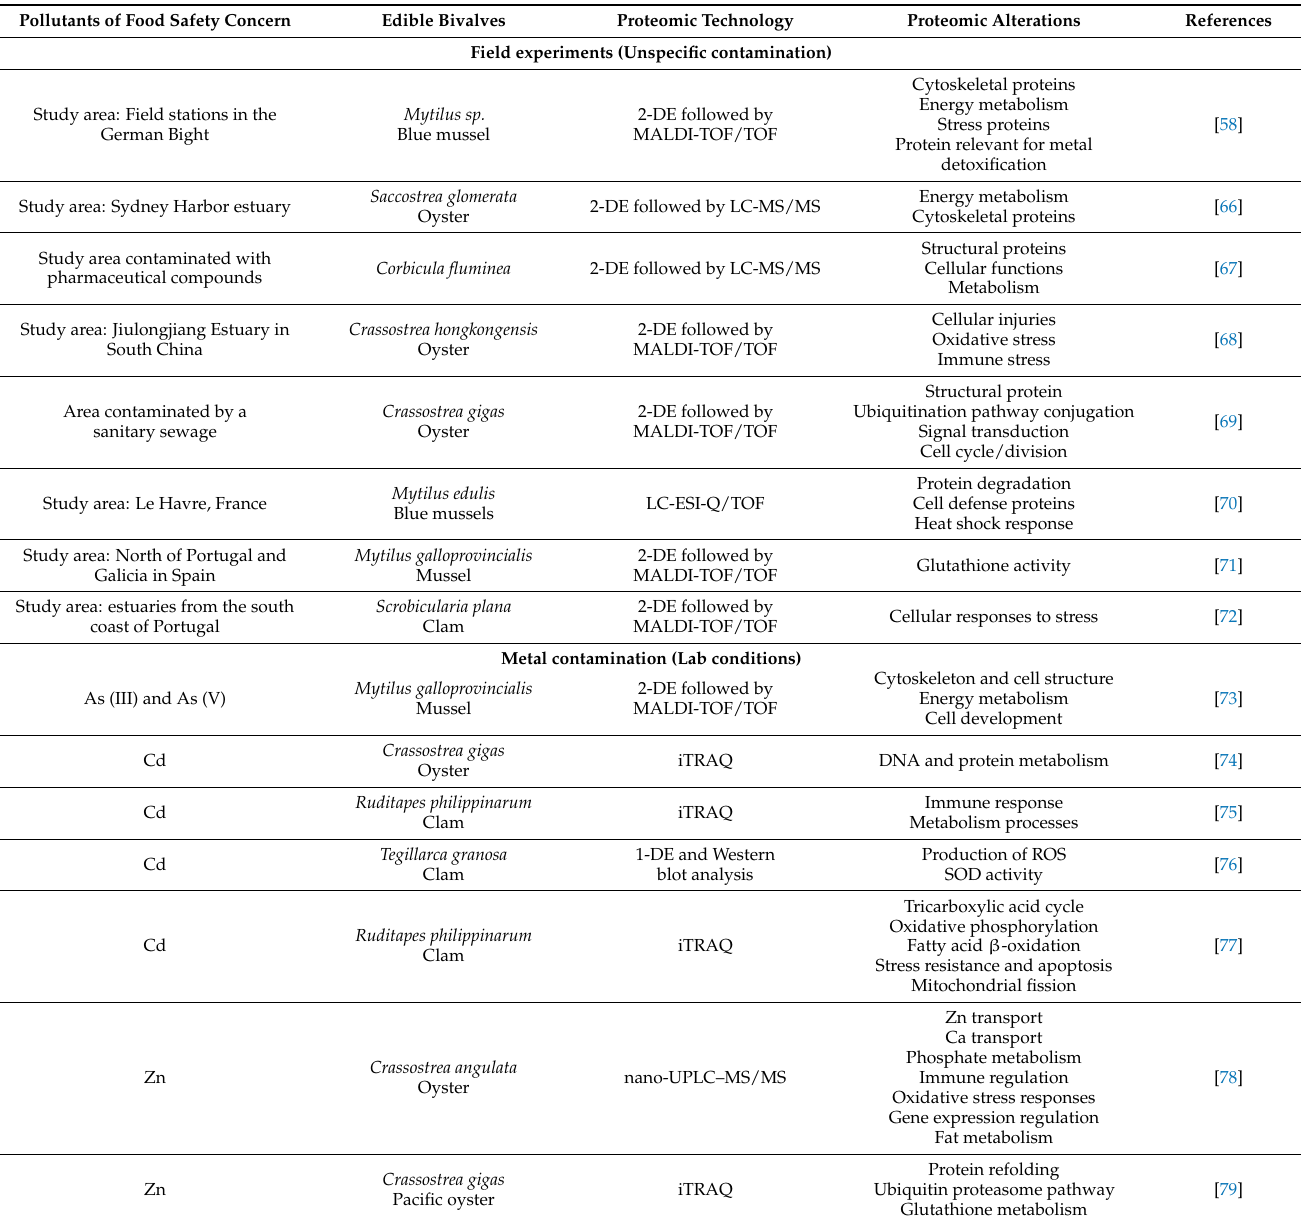
Table 1. A collection of papers focusing on cellular alterations of contaminated seafood using a proteomic